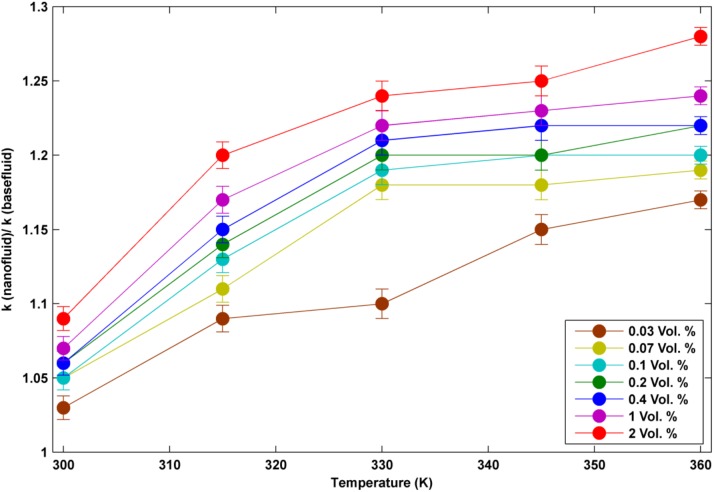
knf/ kbf in different temperatures.